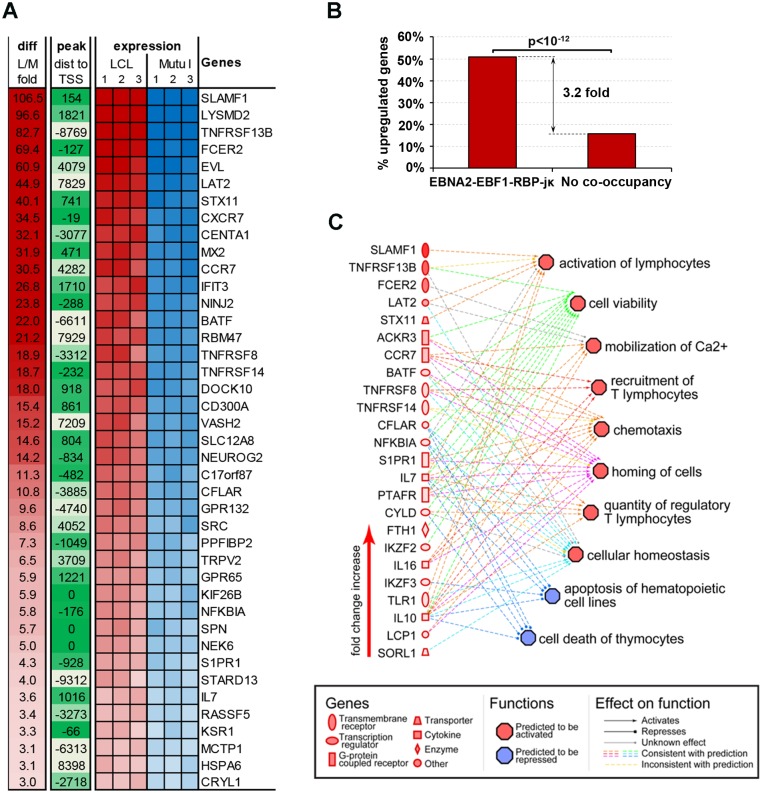
Characterization of cellular genes highly activated by EBF1-RBP-jκ-EBNA2 co-occupancy in LCL.
(A) Heatmap of mRNA expression for genes with co-localized EBF1, RBP-jκ, and EBNA2 and at least 3-fold over expression in LCL relative to Mutu I. (B) Percentage of genes with co-localized EBF1, RBP-jκ, and EBNA2 sites at least 10kb from the TSS that are over-expressed in LCLs relative to Mutu I. (C) Predicted regulation network for LCL over-expressed genes co-occupied by EBNA2, EBF1, and RBP-jκ.